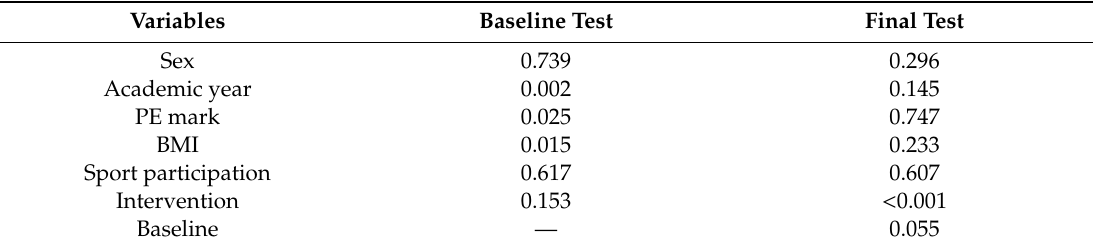
Table 2. E ff ect of variables on the PHR score at baseline and final test.